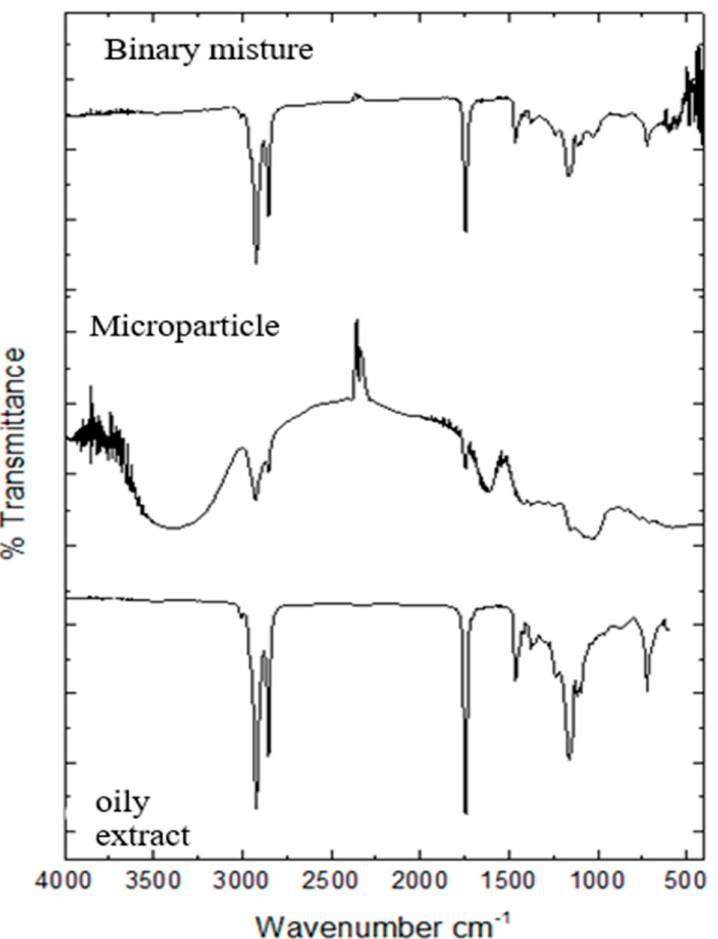
Figure 1. FTIR spectra of the binary mixture of adjuvants, microparticles and oil extract in the absorption range of 4000 to 600 cm − 1 , with 32 scans and 4 cm − 1